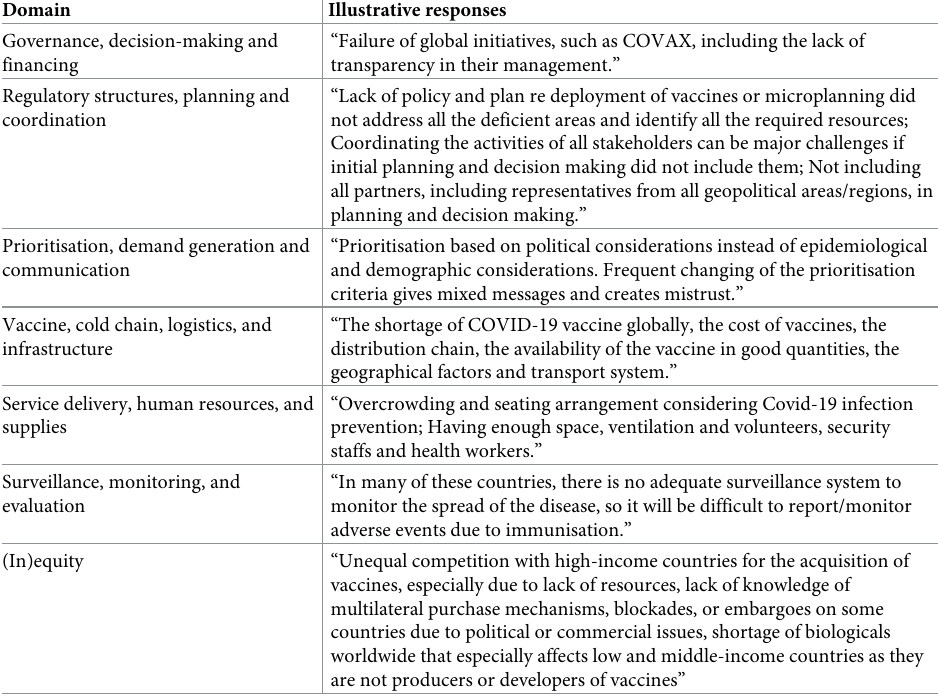
Table 2. Illustrative responses and the building blocks of vaccine program